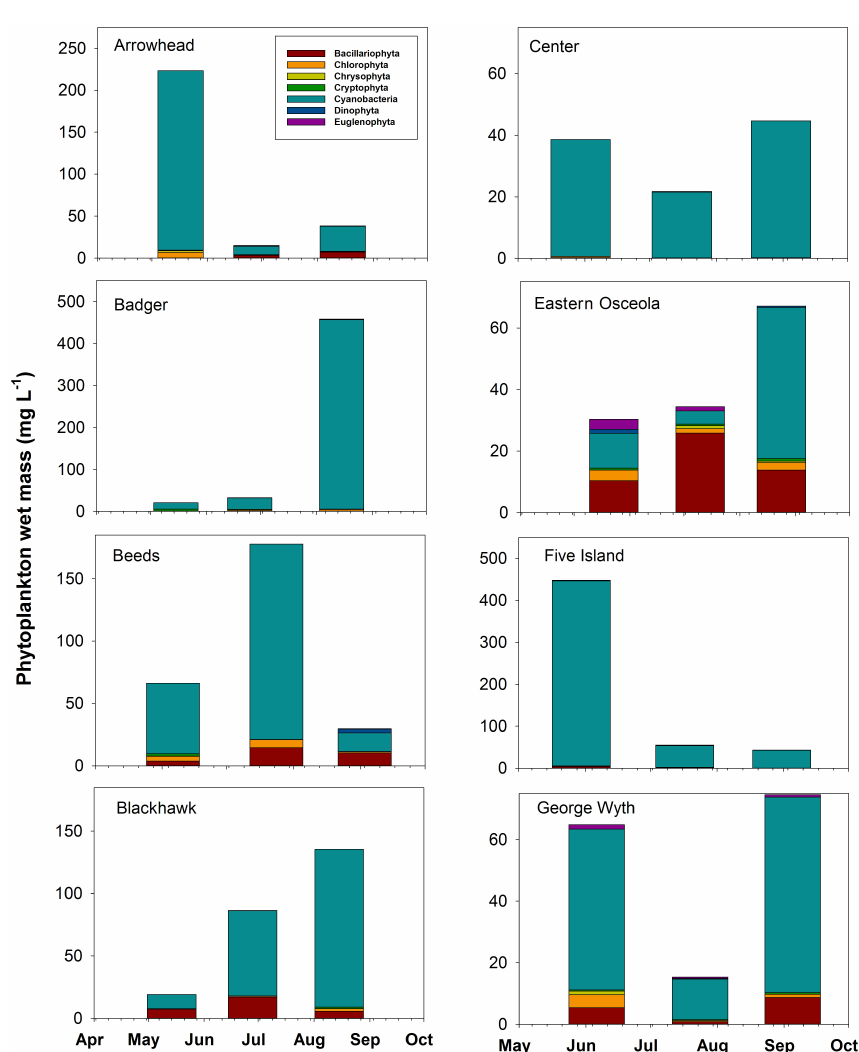
Figure 1. Community composition (division level) and biomass for three summer sampling points in the first 8 of 16